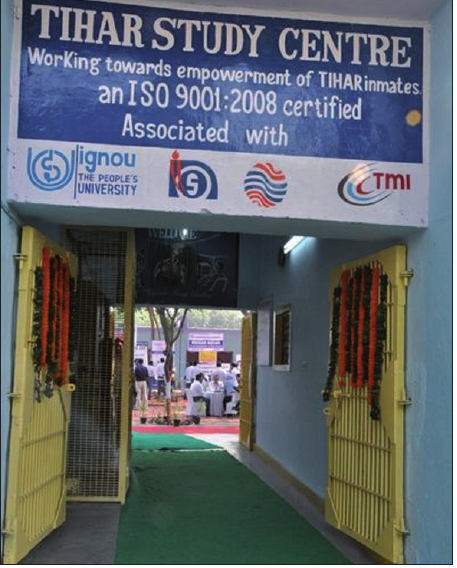
Figure 3 The Tihar Study Centre Source: Photo courtesy of the Tihar Study